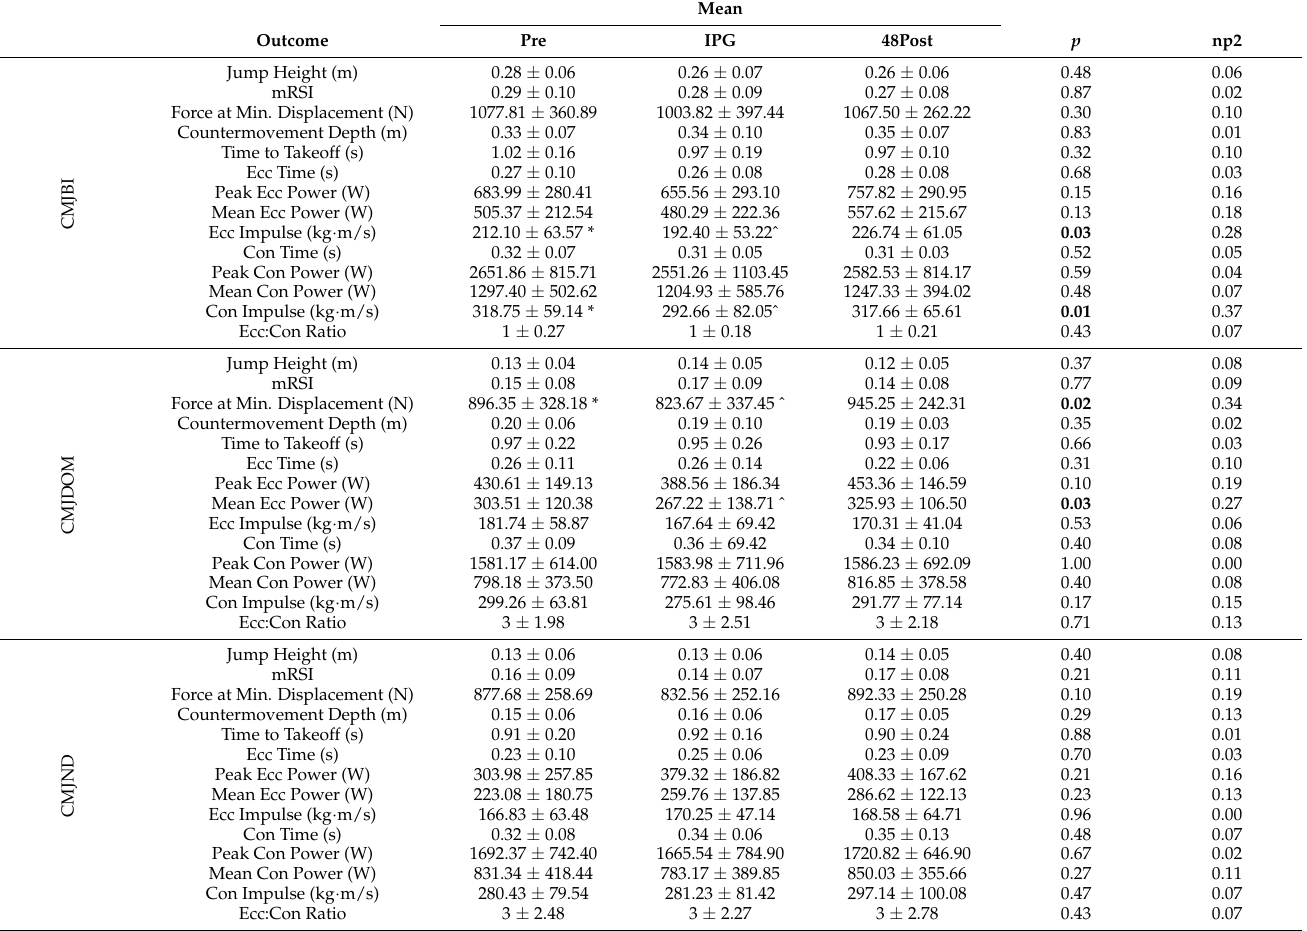
Table 2. The effects of neuromuscular fatigue on CMJ BI , CMJ DOM and CMJ ND .